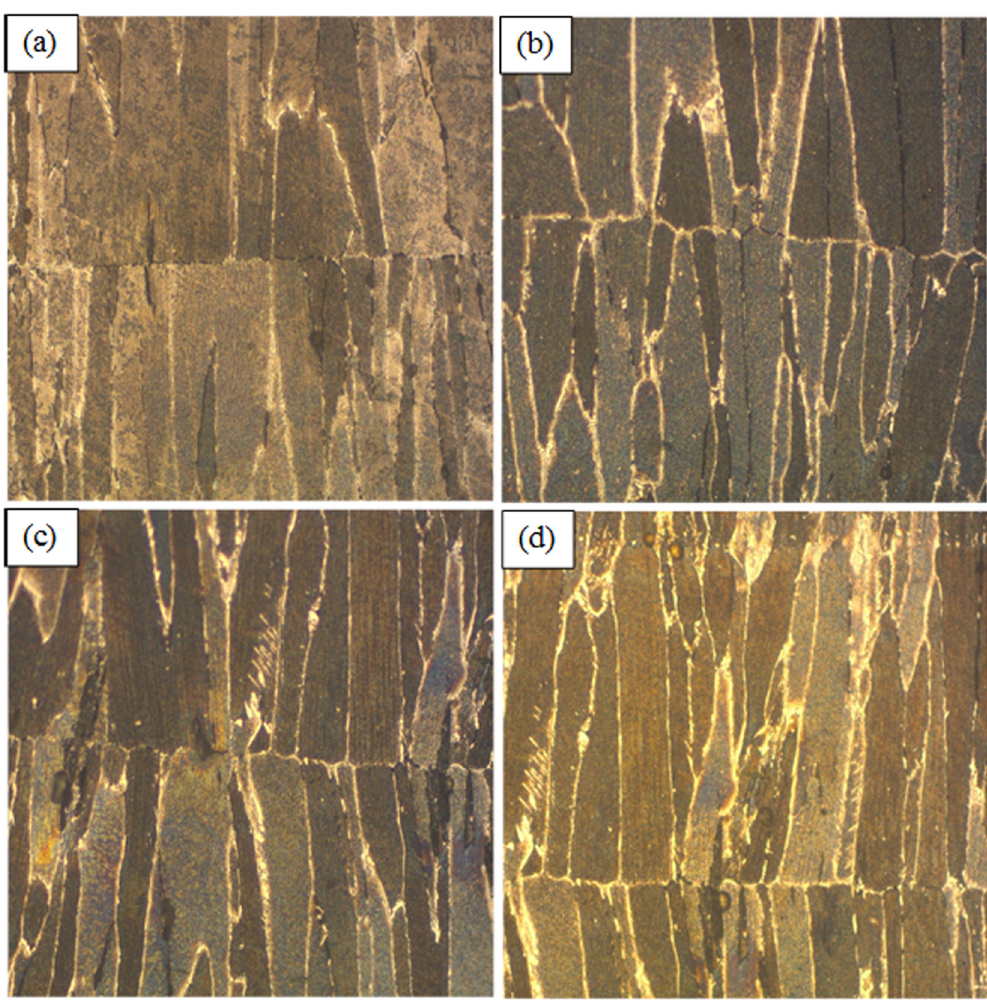
Figure 4: Effect of welding current on microstructure with 6 mm electrode tip diameter: ( a ) 4 kA, ( b ) 5 kA, ( c ) 6 kA and ( d ) 7